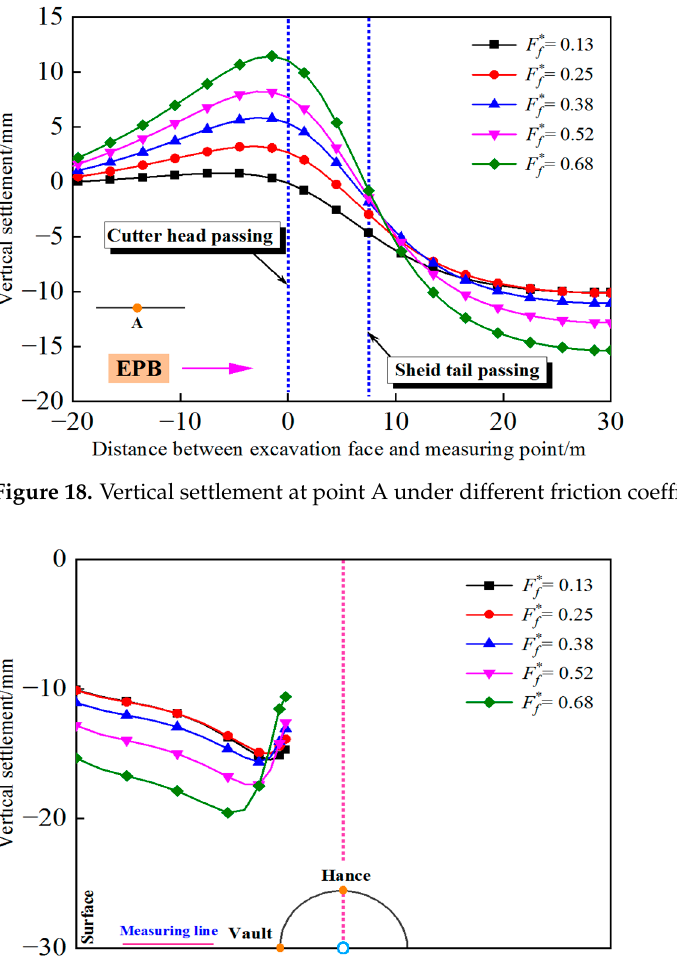
Figure 19. Vertical deformation of the stratum under different friction coefficients F ∗